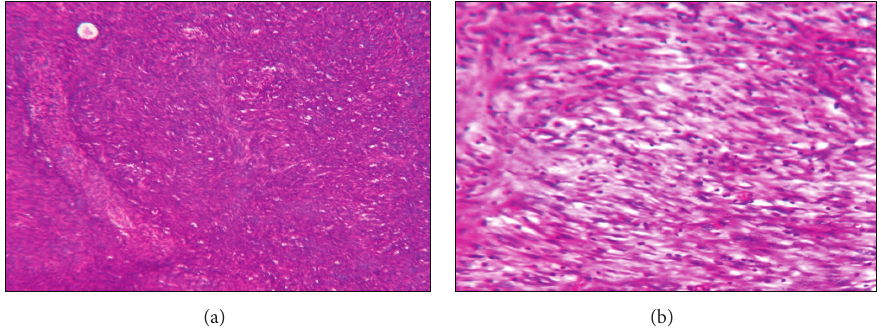
Figure 1: Histology of the ovarian sections. (a) H&E × 100 magnification showing neoplasm made up of proliferated spindled, oval cells with entrapped ovarian follicles. (b) H&E × 200 magnification of the same section in (a).